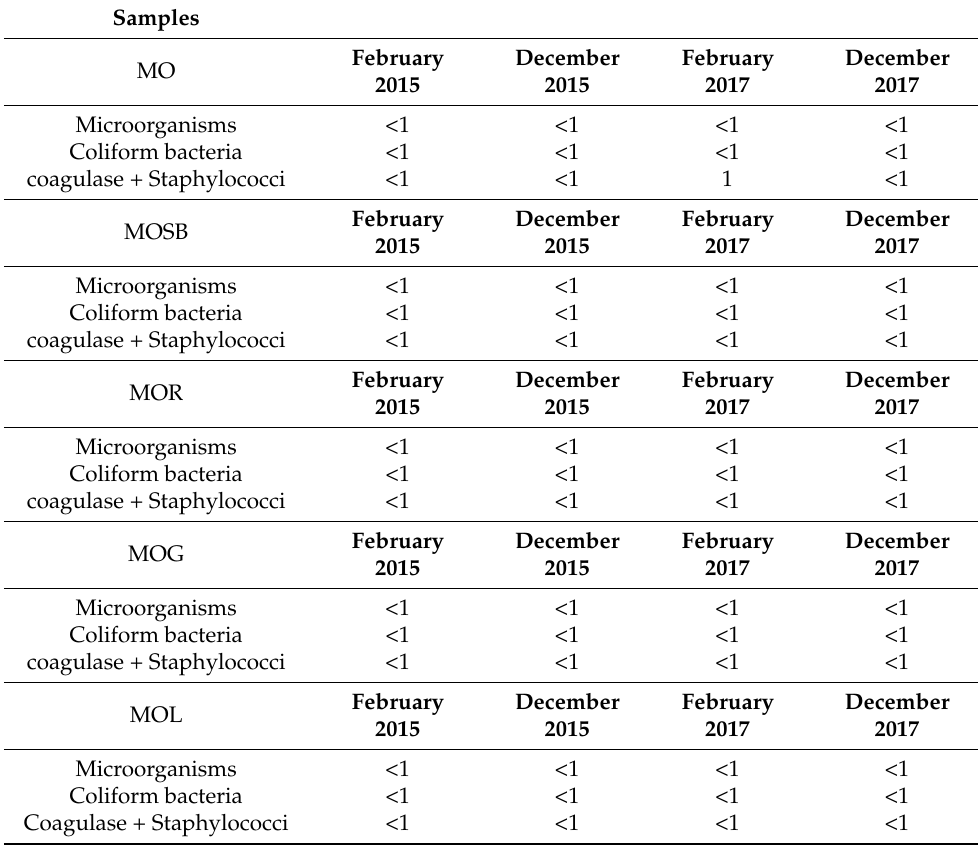
Table 13. Microbiological analysis (CFU/g) of all olive